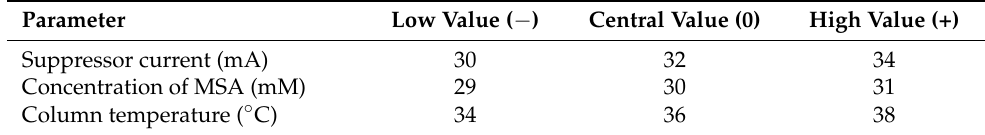
Table 10. Chromatographic parameter settings applied in the experimental design of the robustness study. Parameter Low Value ( − ) Central Value (0) High Value (+) Suppressor current (mA) 30 32 Concentration of MSA (mM) 29 Column temperature ( ◦ C)